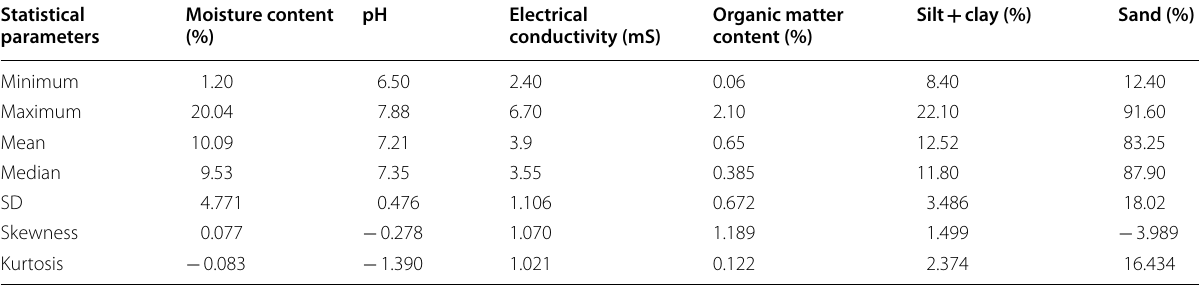
Table 13 Statistical parameters of the physicochemical parameters of the sediment